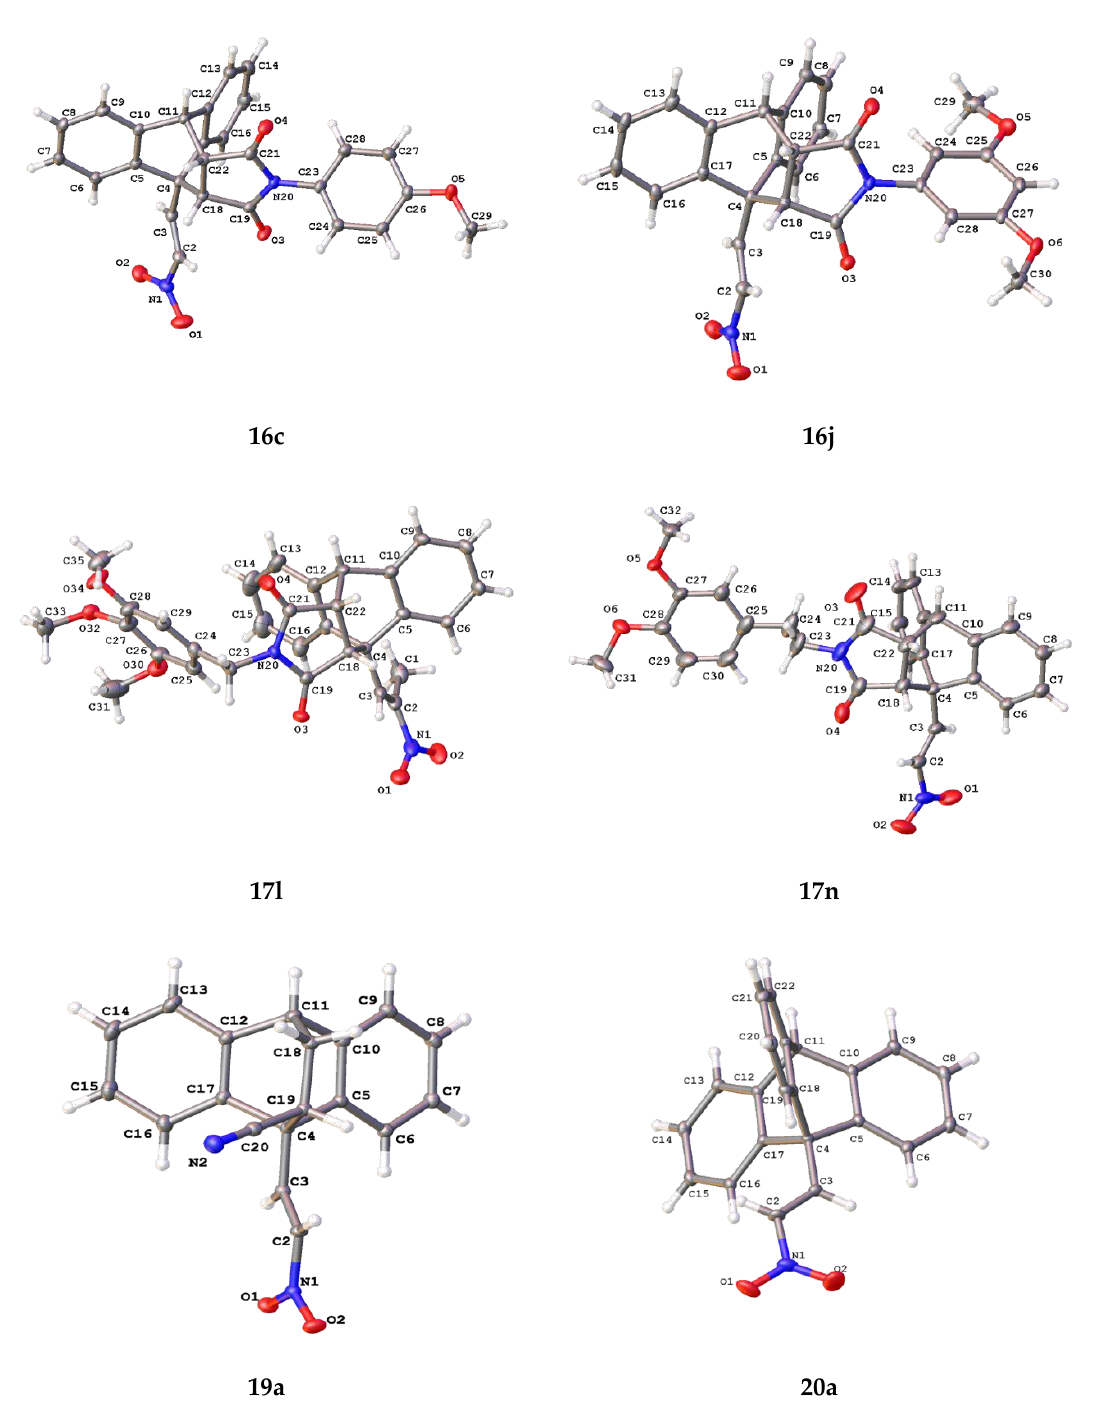
Figure 2. X-ray crystallographic molecular structures of 16c , 16j , 17l , 17n , 19a and 20a with atomic displacement shown at 50% probability. Only major disordered moiety shown for 17l . Non-hydrogen atoms labelled where possible. Table 4. X-ray crystallography data for compounds 16c , 16j , 17l , 17n , 19a and 20a .